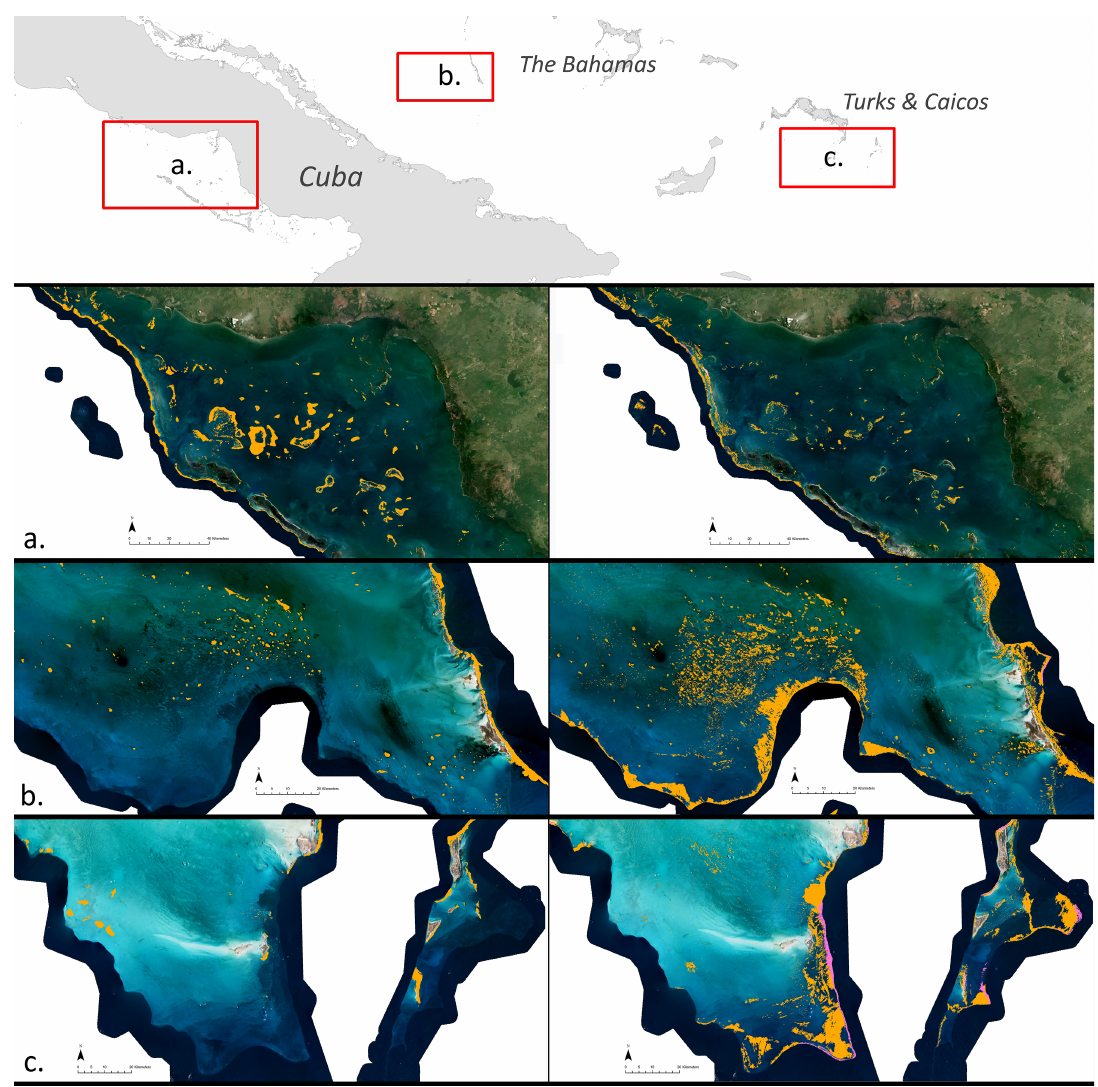
Figure 17. Comparison of mapped coral reef extent using the current UNEP-WCMC Global Distribution of Coral Reefs (Version 4.1) data (left side) and the PS-derived coral reef maps for three areas in ( a ) Cuba; ( b ) The Bahamas; and ( c ) Turks and Caicos Islands. Reef area in Cuba is overrepresented in the global maps and underrepresented in The Bahamas and Turks and